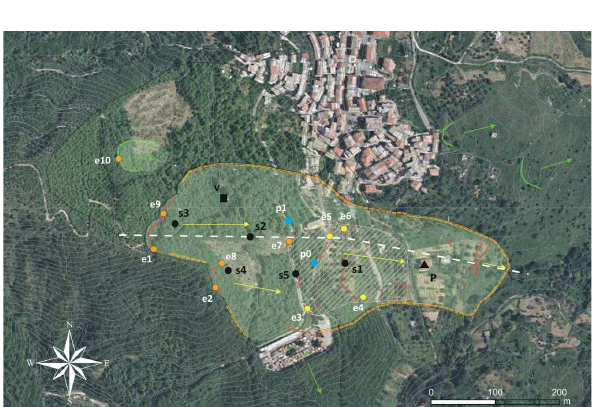
Fig. 3. Geomorphological scheme of the San Rocco slope move- ment (after Iovine et al., 2009, mod.). (Key) in red: main fractures opened during the first phase of mobilization (January–May 2009); green hatched area: ancient, inactive landslide; pink hatched area: portion of the landslide that showed the greatest evidence of mobi- lization on both activations, with opening of new springs; yellow ar- rows: average directions of displacement, as determined from field evidence; in green: fractures and directions of movement of other active gravitational phenomena; S 1 − 5 : boreholes drilled in sum- mer 2009 (black dots); e 1 − 10 : extensometers (e 1 − 6 active since February 2009; e 3 − 6 inactive since February 2010; e 7 − 10 active since February 2010); p 0 − 1 : meteoric station (blue dots: p 0 active from April 2009 to February 2010; p 1 active since March 2010); black triangle: the building “P”; black square: cistern of the water system (“v”); white dashed line) profile considered in the paramet- ric analyses (cf. Figs. 10–14). A piezometer was installed in S 1 ; S 2 − 5 were equipped with inclinometers. The threatened area is ev- idenced in light-green, and bordered with an orange dashed